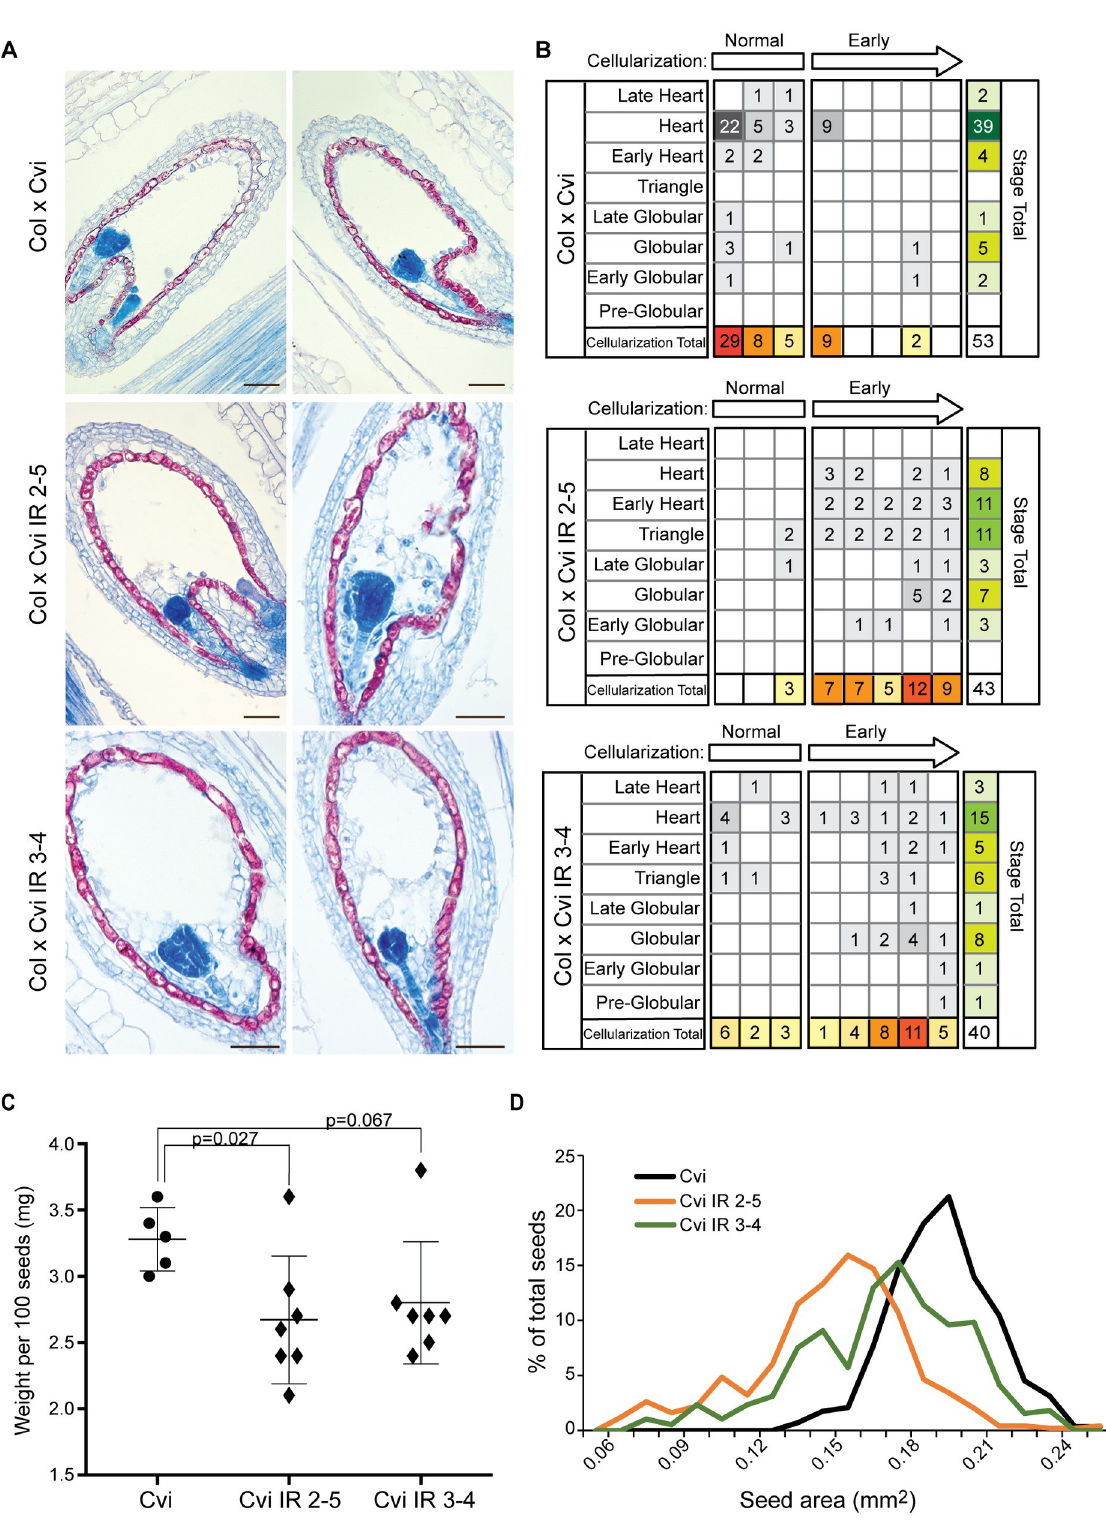
Fig 6. Effects of HDG3 imprinting on Cvi seed development. (A) Aniline blue and safranin O staining of seed sections at 5 DAP from the indicated F 1 seeds. Scale bars, 50 μ m. (B) Phenotypic characterization of sectioned seeds, assaying degree of endosperm cellularization relative to embryo stage. (C) Seed weight in selfed Cvi and Cvi HDG3 IR plants. Individual data points and mean +/- SD shown.